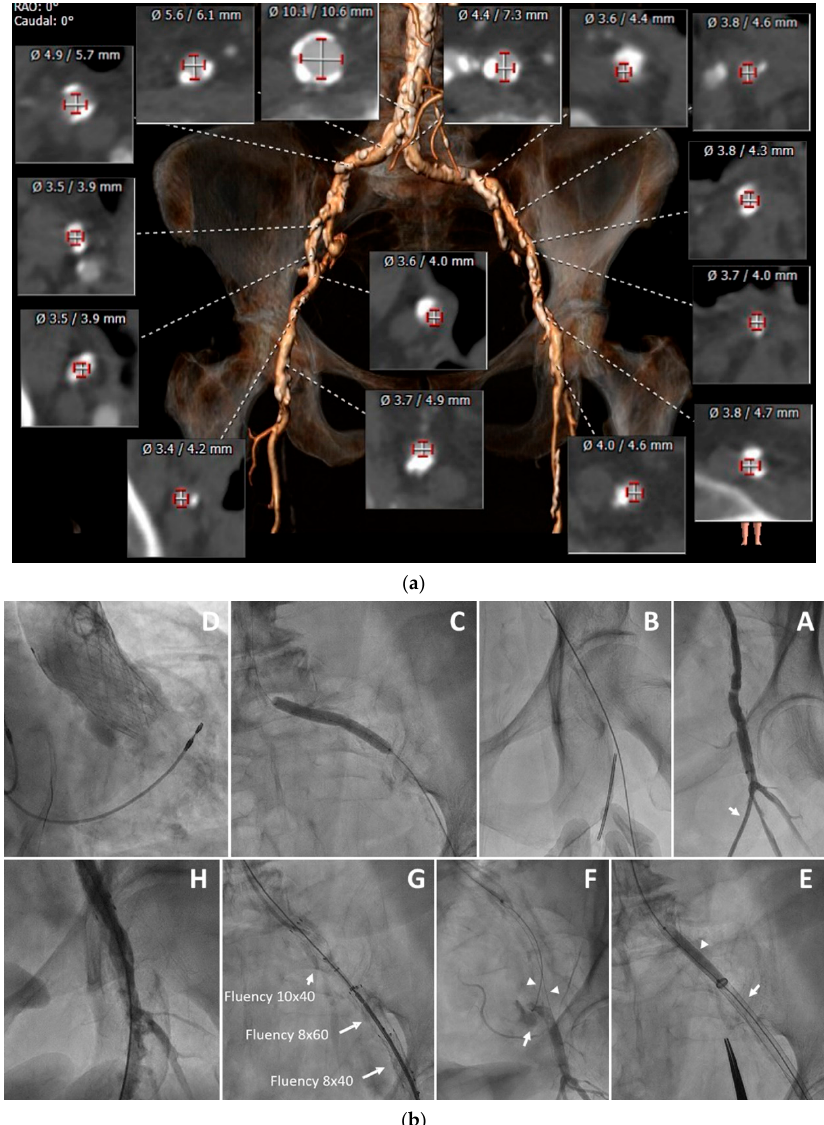
Figure 4. Use of multiple modalities in a patient with hostile vascular anatomy. An 89-year-old female with severe PVD and severe symptomatic aortic stenosis was referred for TAVR. ( a ) CT angiography revealed extremely calcified and stenosed ileofemoral arteries, with minimal diameters of 3.5 mm. ( b ) The TAVR procedure was performed via the left femoral artery, with two safety wires inserted; antegrade via the right brachial artery and retrograde via the left superficial femoral artery (SFA). ( A ) A 5Fr sheath was inserted into the left SFA (arrow). ( B ) The left common femoral artery was then punctured and pre-closure with a Proglide device was performed. ( C ) The left iliac artery was dilated with a 6 mm Shockwave balloon at 6 atmospheres and a 6 mm non-compliant balloon at 24 atmospheres. ( D ) A 26 mm Evolut Pro valve was delivered over a stiff Lunderquist wire and implanted. ( E ) An occlusive 7 mm balloon (arrowhead) was delivered via the right brachial artery and inflated within the proximal left iliac artery prior to sheath removal (arrow). ( F ) Control angiography of the left femoral artery, which was performed via the left SFA following removal of the 16 Fr sheath and fastening of the Proglide sutures, revealed vessel perforation (arrow) and location of both safety wires (arrowheads). ( G ) Three overlapping stent grafts were implanted within the ileofemoral artery. ( H ) Repeat angiography confirmed adequate hemostasis. The SFA and brachial sheaths were removed following administration of protamine